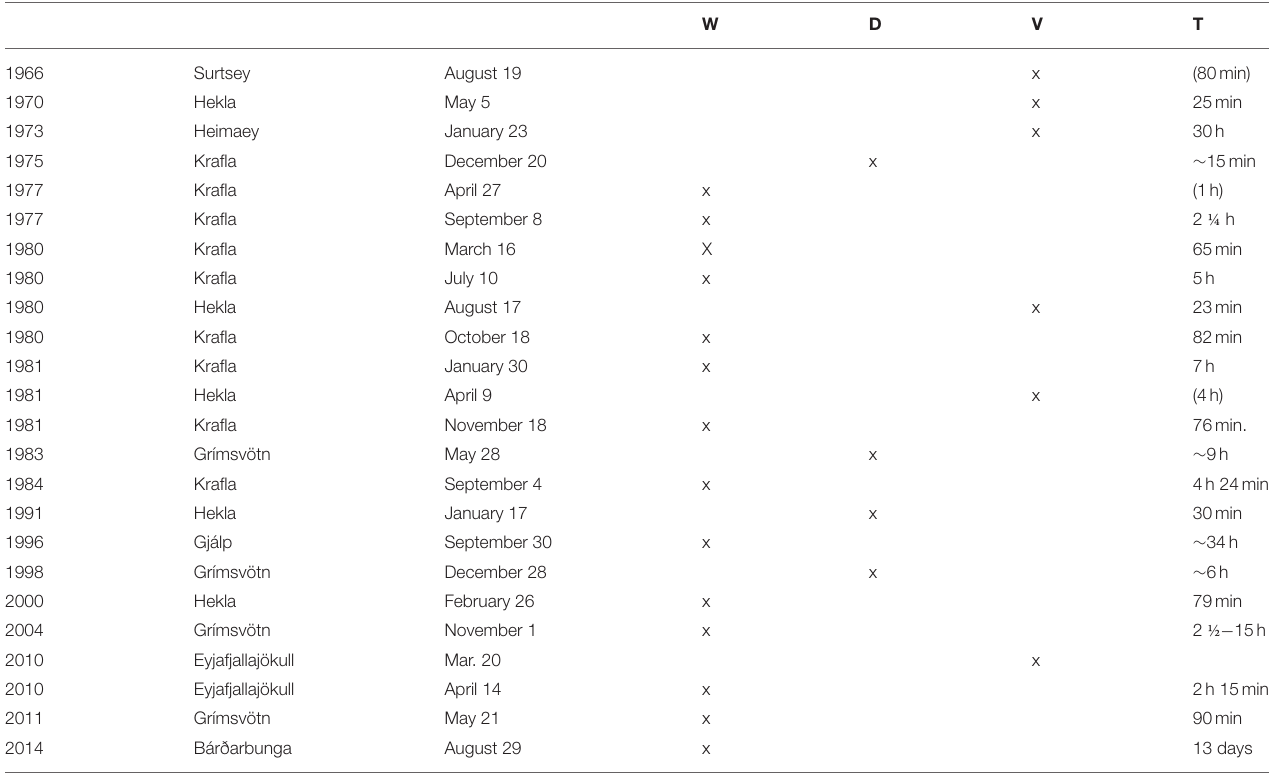
TABLE 1 | Short-term precursory activity and precursory